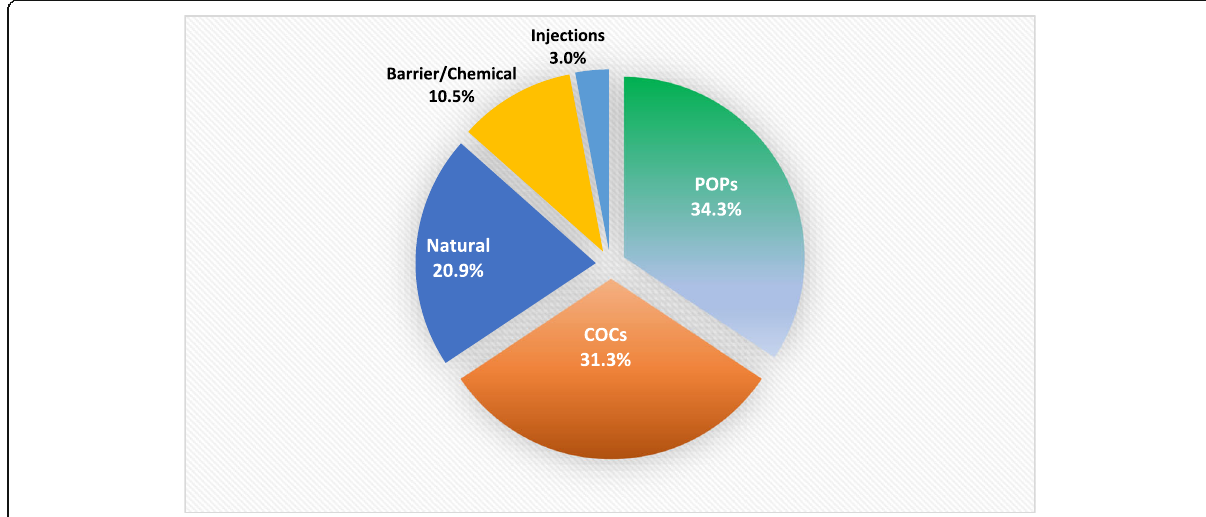
Fig. 2 Contraceptive failure among women with unintended pregnancy in Sohag district, 2016